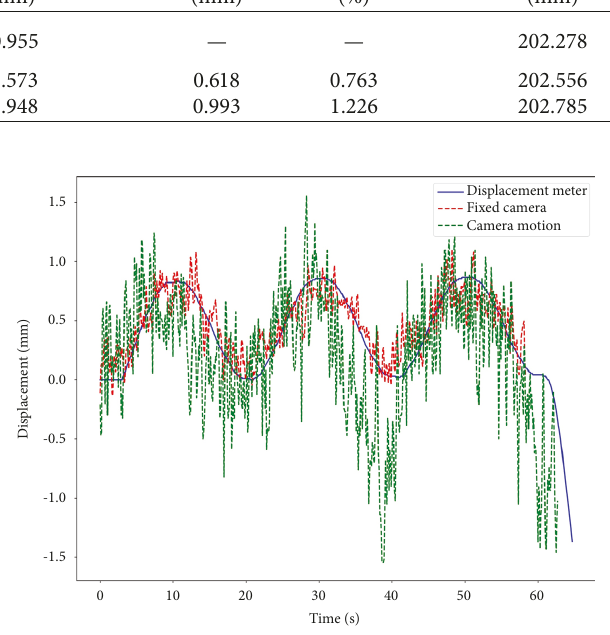
Figure 10: Vertical displacement time history achieved by various displacement measurement methods. Table 4: Peak vertical displacement achieved by various displacement measurement